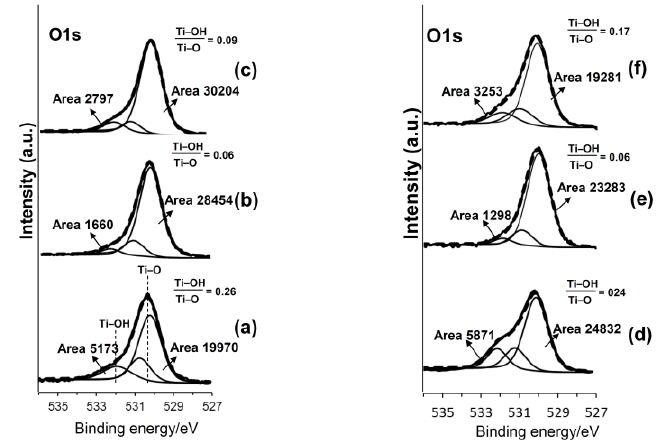
Figure 4. XPS profiles of O1s on Ti that was initially soaked in NaOH solution and then subjected to ( a ) 100Ca + 0.05Ga; ( b ) subsequent heat, and ( c ) final water treatment, or ( d ) 100Ga; ( e ) subsequent heat, and ( f ) final water treatment. Thick line represents spectrum. Thin lines represent deconvolution lines. Dot line represents composite line.